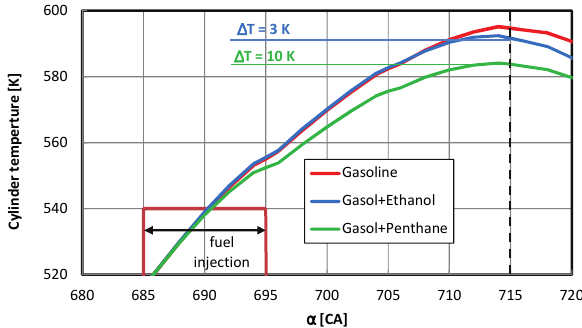
Fig. 12. The cylinder pressure and temperature value course during com- pression and decompression strokes Diverse coefficients of fuels' spray are the result of their properties. Due to its lower density, isopentane shows a greater range in typical fuel injection phase (up to 715 o CA) (Fig. 13), what was confirmed in spatial research of the atomized fuel spray. The value of isopentane spray range is higher at about 8%, and of ethanol at 2% versus that of gasoline (at 715 o